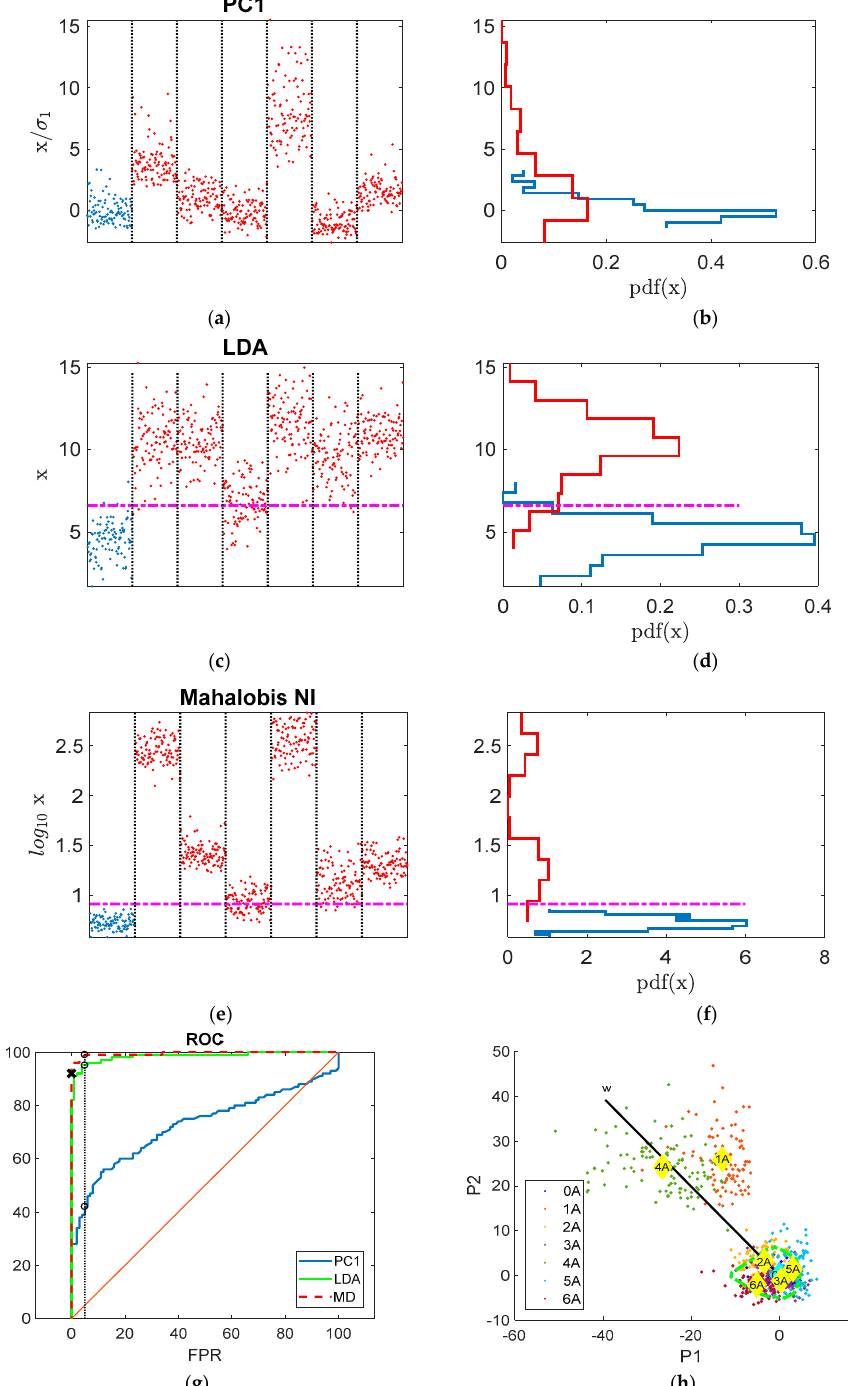
Figure 15. Results for condition 3 ( 90 Hz,1400 N ) alone ( a , c , e ) the 3 different dimensionality reductions; ( b , d , f ) the corresponding empirical pdf for the healthy condition (blue) and for the 6 damage conditions (red). The x axis represents the 100 observations for each of the different damage conditions (ordered from 0A to 6A) which are separated by the black dotted lines. ( g ) ROC curves for the three 1-D reductions. The 5% significance threshold values are highlighted with the black circles; the black x denotes the position of the NI threshold computed according to the MC repetition introduced in Section 2.4.1—in magenta in ( h ) The 2-D PCA visualization of the dataset (condition 12) and the LDA direction 𝑤 .